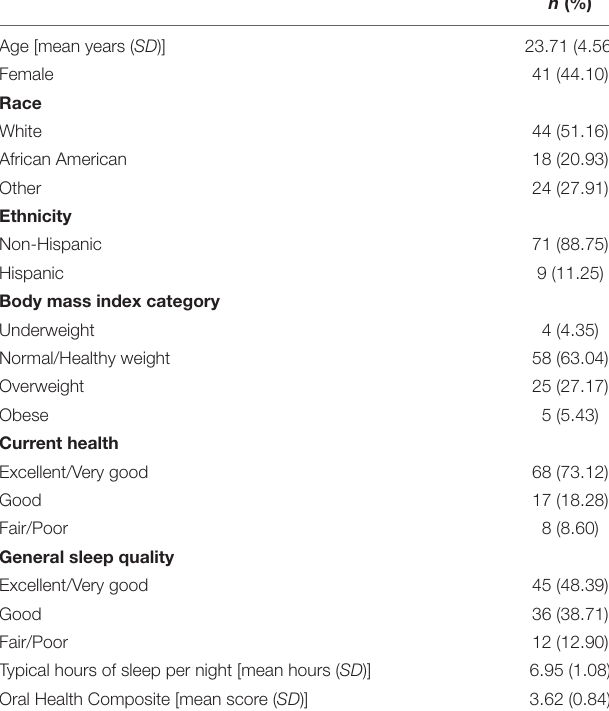
TABLE 1 | Participant